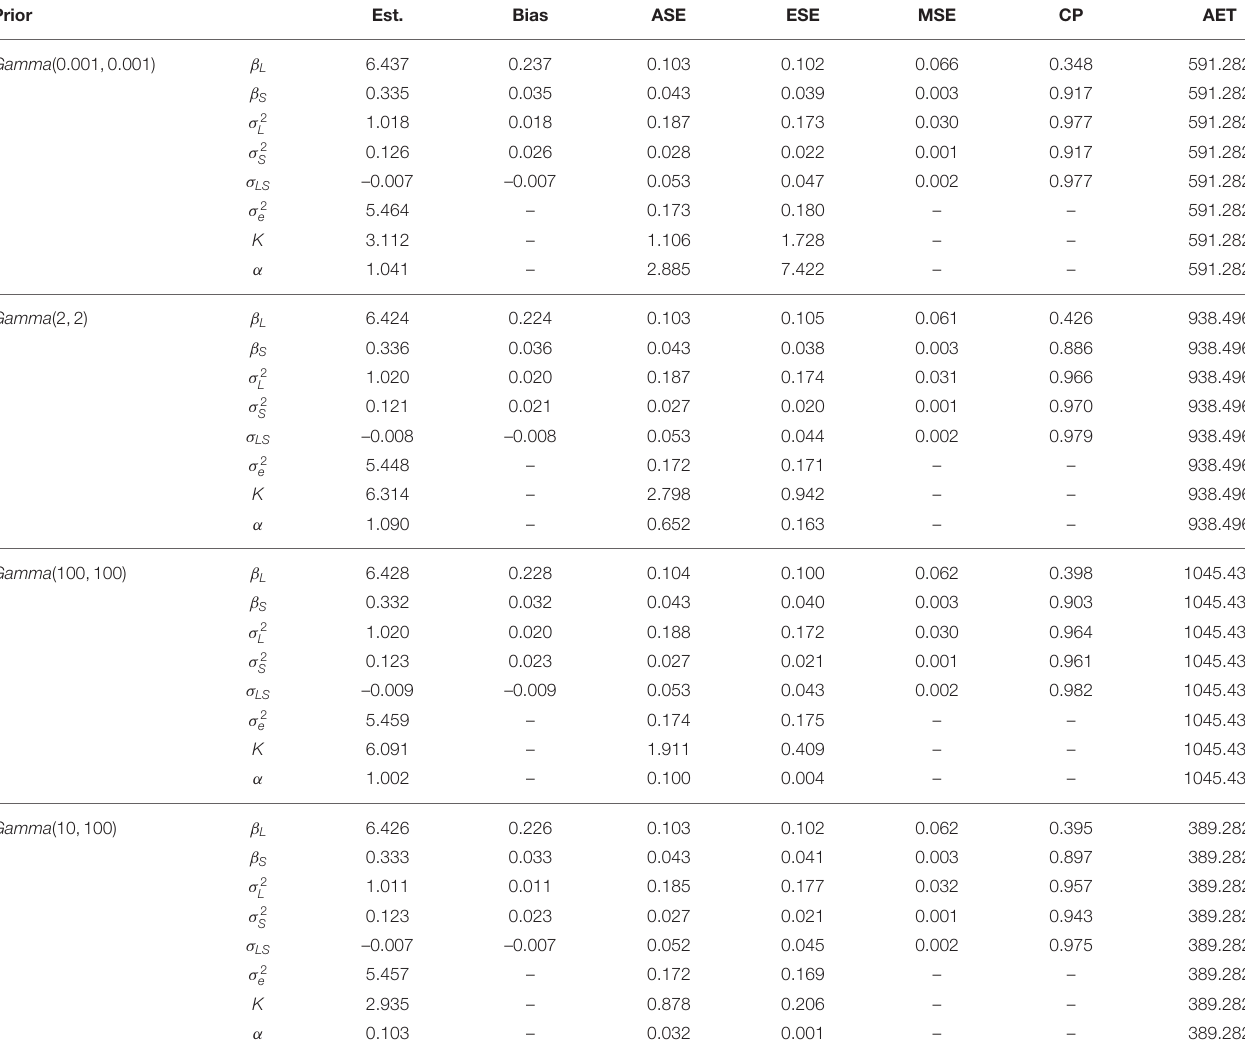
TABLE 4 | Model estimation for BNP growth curve modeling with different precision parameter priors when data contain 10% of outliers and N = 200. Prior Est. Bias ASE AET Gamma